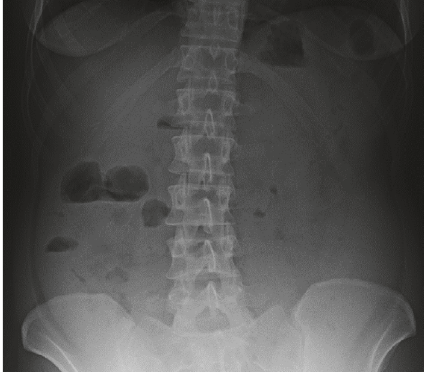
Figure 1: X-ray showing levels in the upper right quadrant of the abdomen.